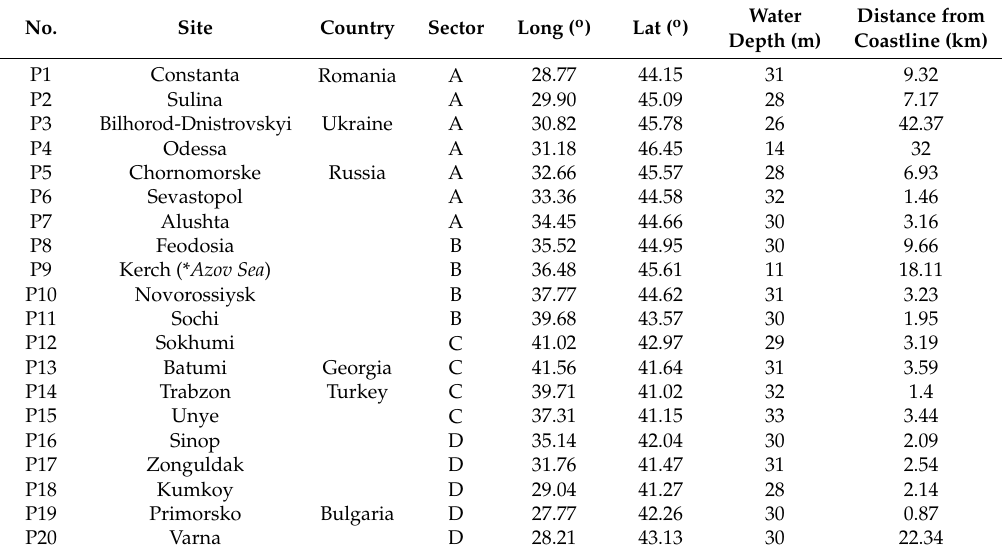
Figure 1. The Black Sea area and the location of the reference sites (map from Google Earth, 2018). Table 1. The main characteristics of the sites considered.